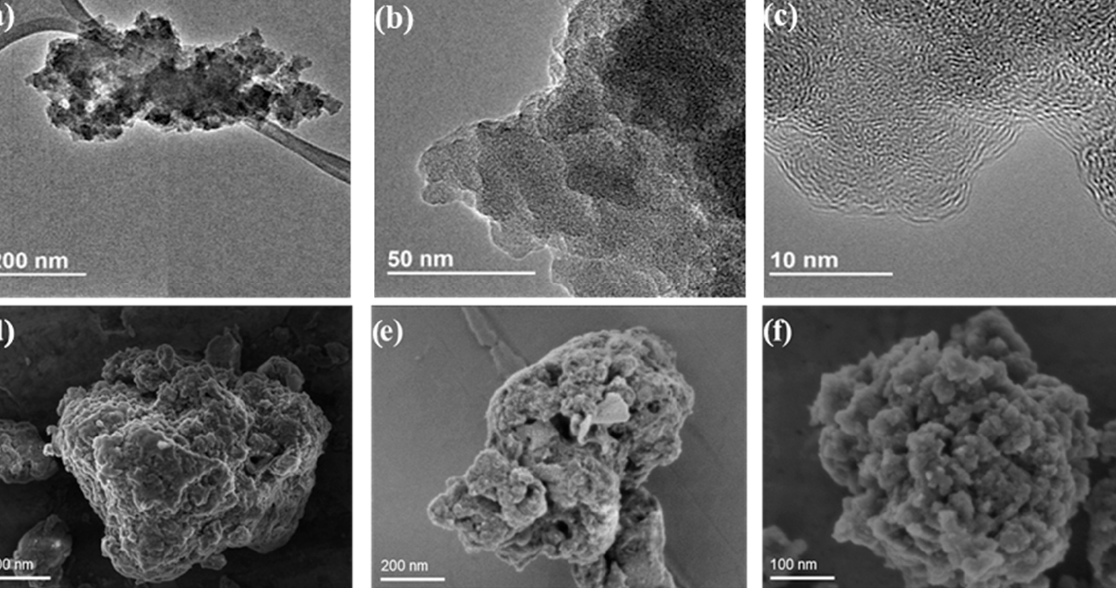
Figure 3. TEM images of COP–3 ( a – c ) and SEM images of COP–1 ( d ), COP–2 ( e ), and COP–3 ( f ).